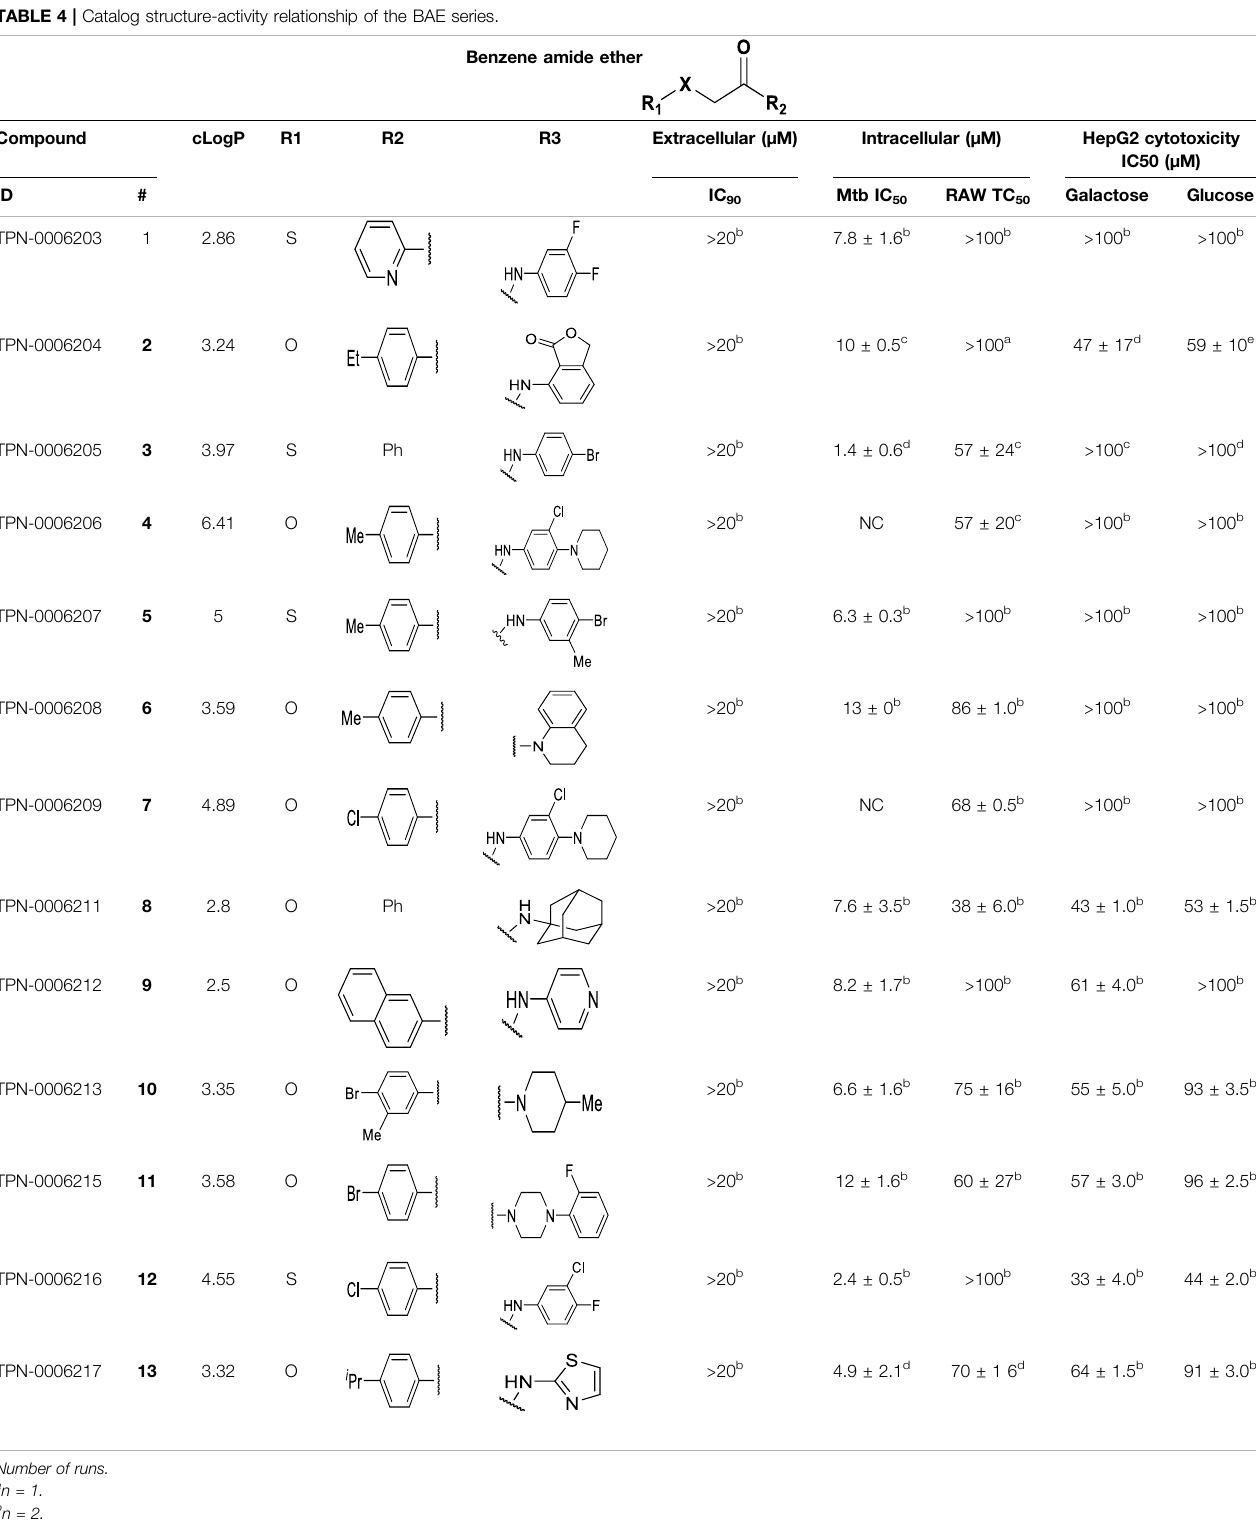
TABLE 4 | Catalog structure-activity relationship of the BAE